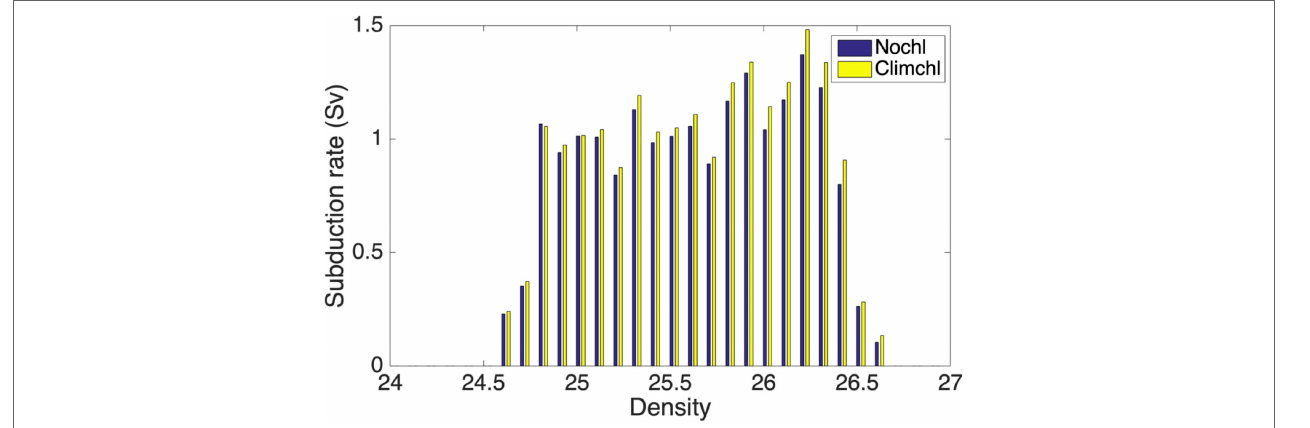
interval of 0.1 kg m -3 in the northwestern and central Pacific (145°E-160°W, 29°N-42°N) for the NOCHL run (blue bars) FIGURE 8 | Subduction rate (Sv) for each σ θ and CLIMCHL run (yellow